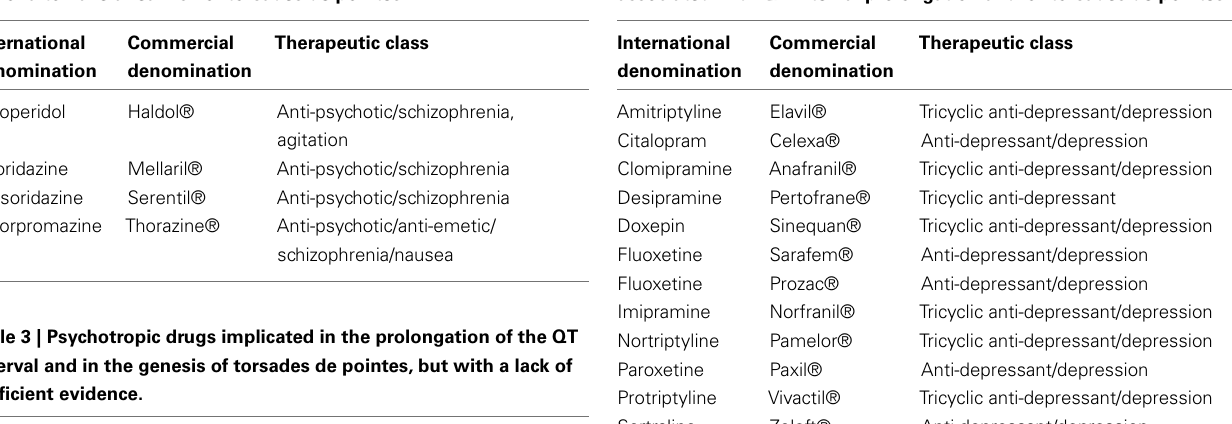
Table 2 | Psychotropic drugs recognized by theAdvisory Council of Arizona to have a real risk of torsades de pointes.